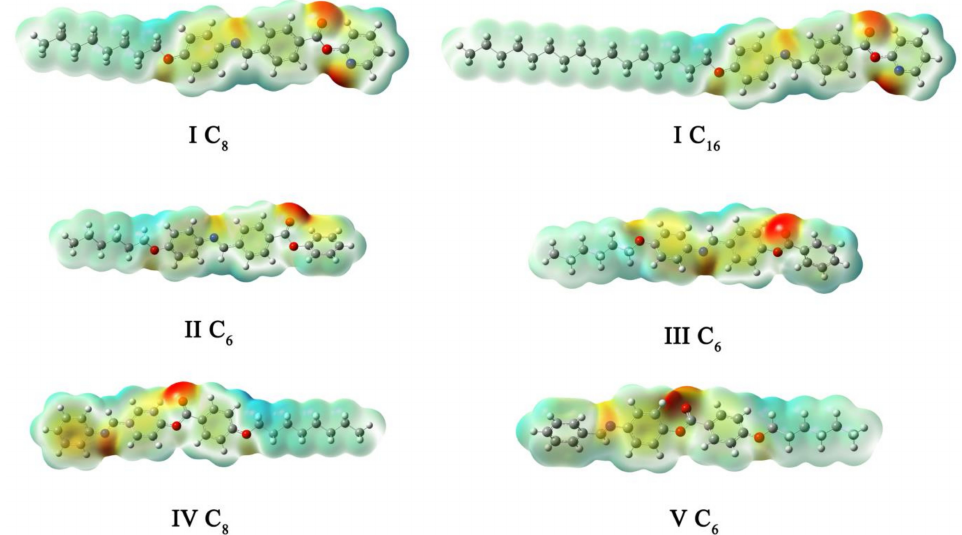
Figure 8. The estimated molecular electrostatic potentials (MEP) of compounds I C 8 , I C 16 , II C 6 , III C 6 , IV C 8 , and V C 6 .